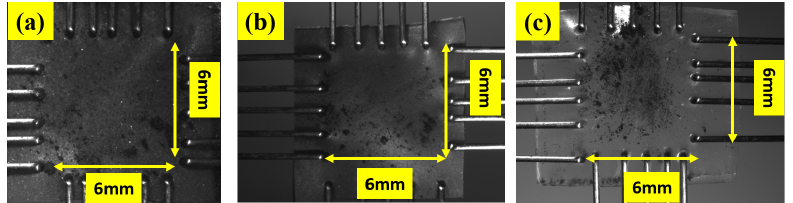
Figure 2. Dimension of specimens used for biaxial testing of three different elastomers ( a ) Latex ( b ) Oppo and ( c ) Ecoflex